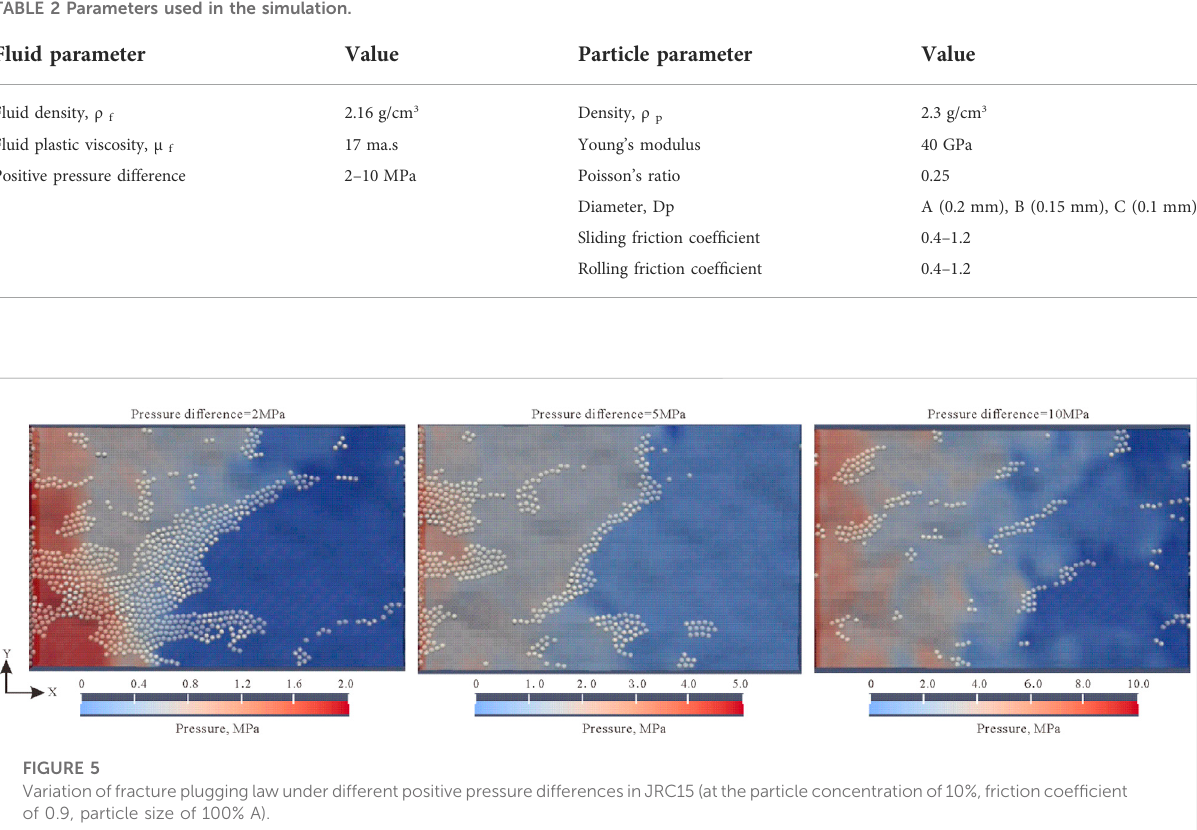
TABLE 2 Parameters used in the simulation.